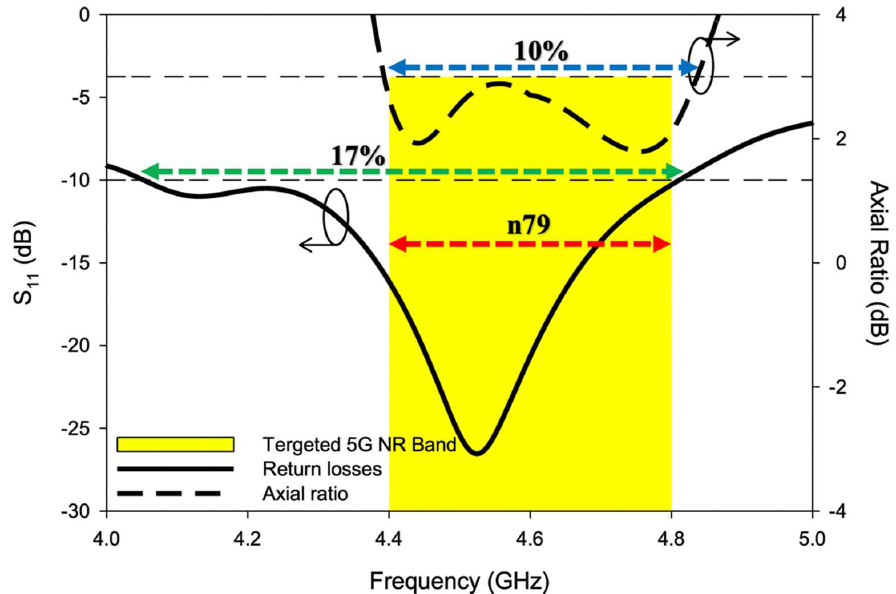
Figure 7. S11 and AR ratio overlapping bandwidths of the CP 5G RDRA.